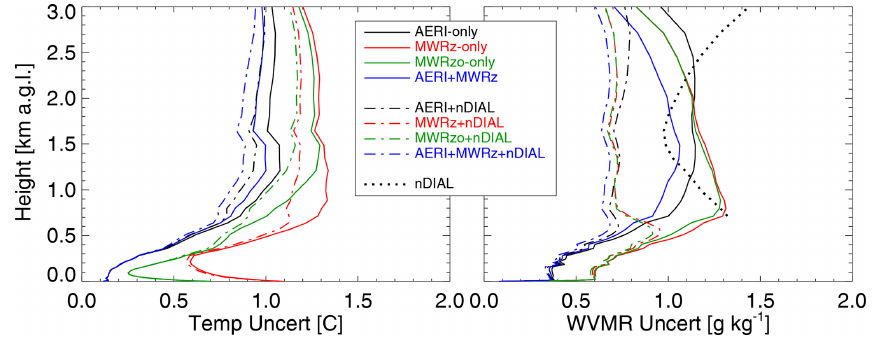
Figure 3. The mean uncertainty in temperature (left) and water vapor mixing ratio (right) for passive-only (solid lines) and active + passive (broken lines) retrievals during Perdigão. The black dotted line is the mean uncertainty from the